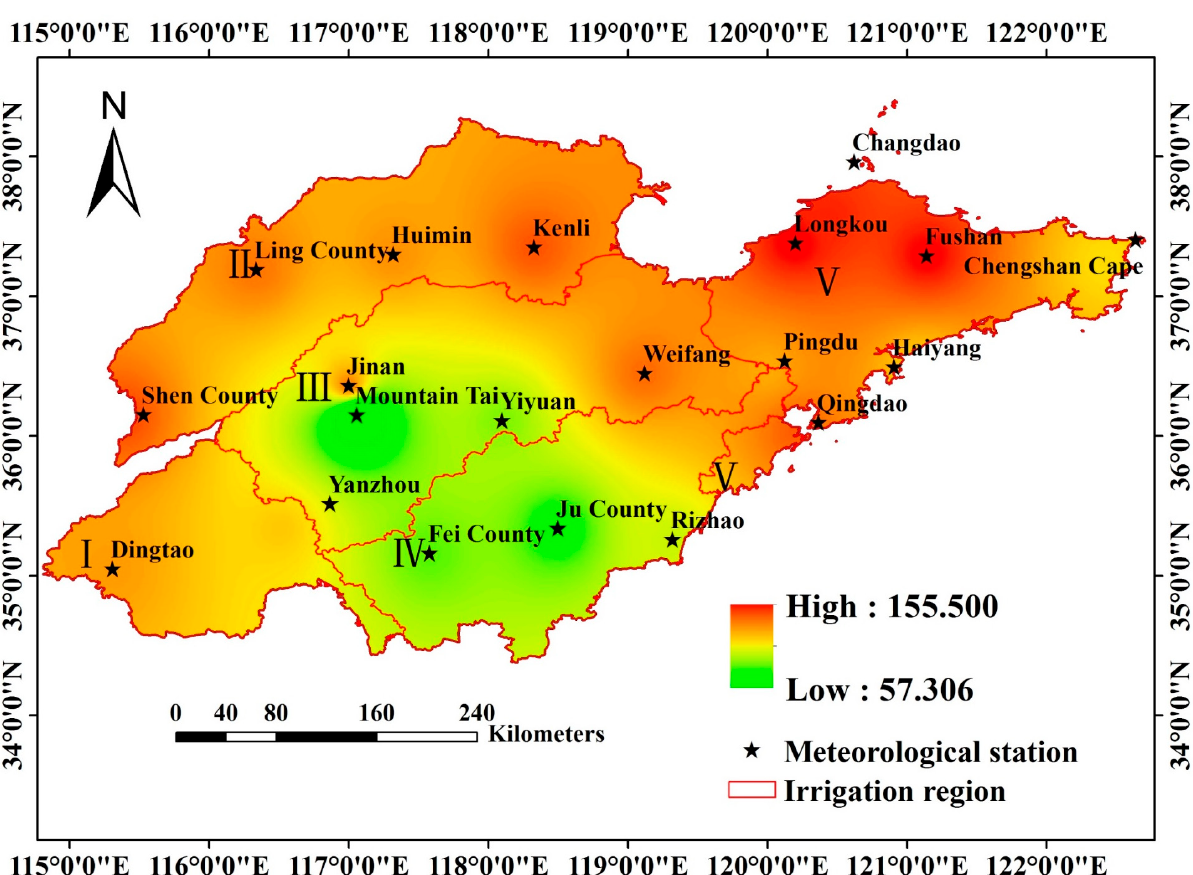
Figure 6. Spatial distribution of annual average irrigation water requirements of summer maize.